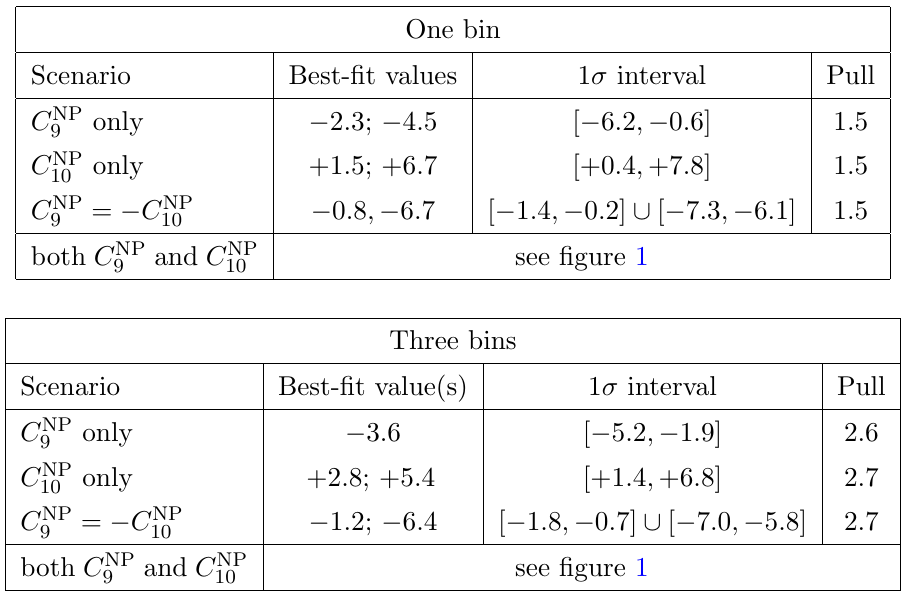
and C NP in di(cid:11)erent scenarios. \One bin" 9 10